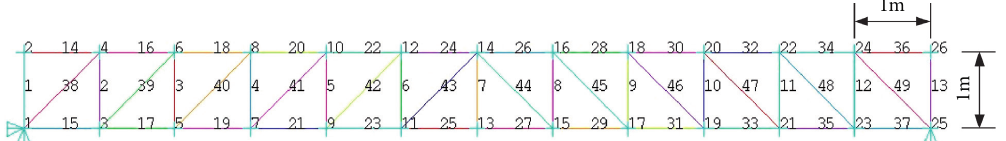
Figure 3: FEM of the plane truss.